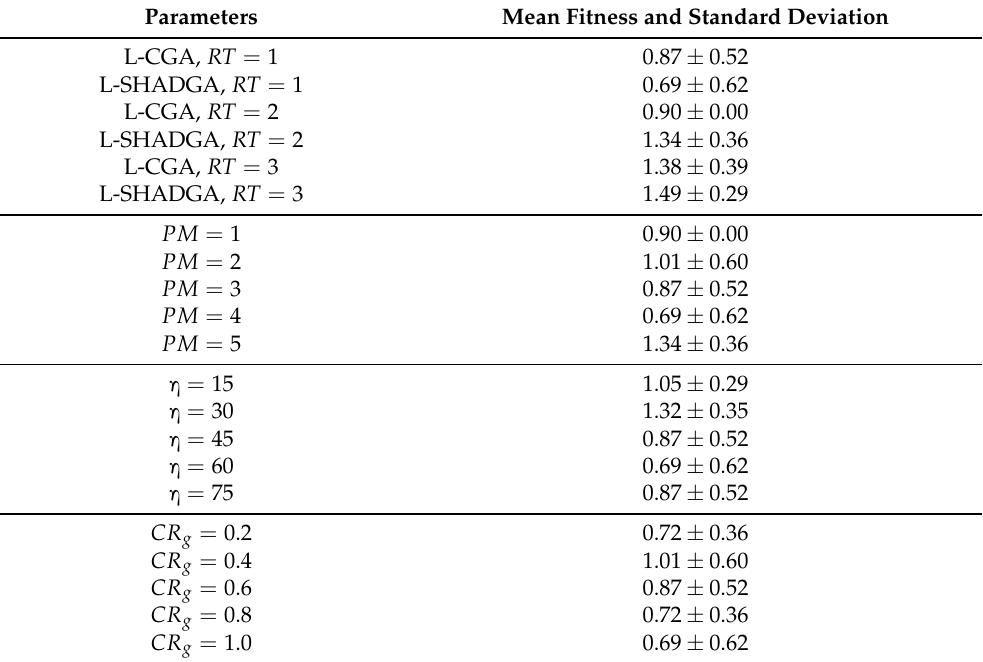
Table 3. Experimental results for 6-mode micrsostrip